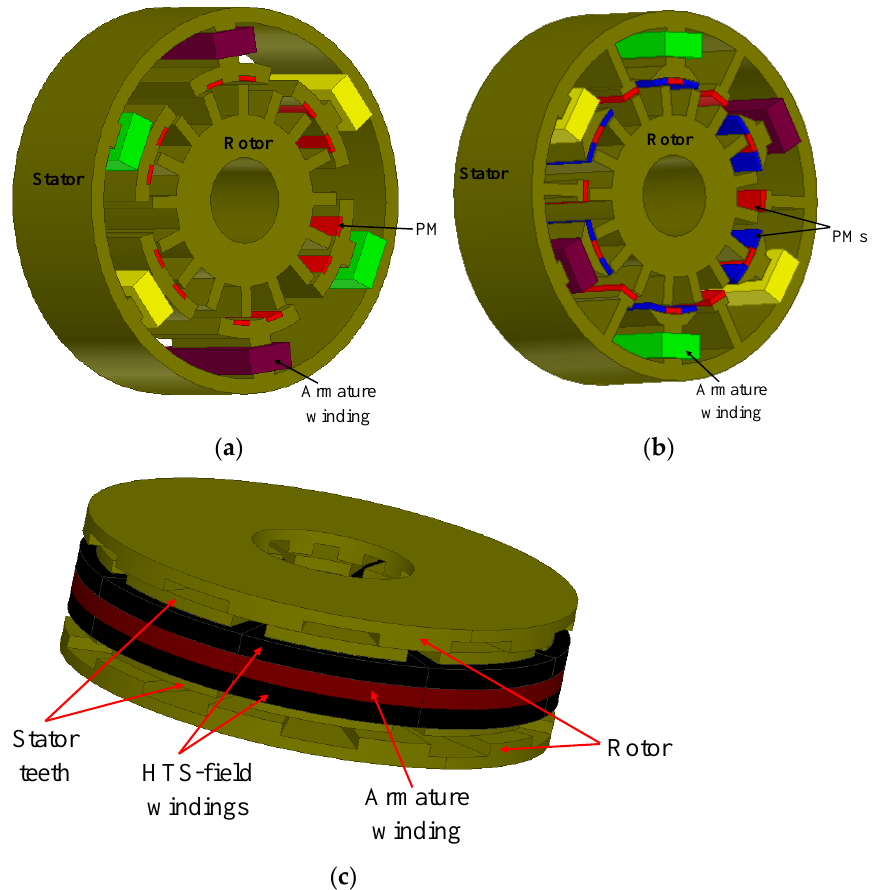
Figure 13. Emerging designs of flux reversal BSMMs: ( a ) consequent pole FRPMM; ( b ) asymmetry stator pole FRPMM; ( c ) Axial flux high temperature superconductor FRM.